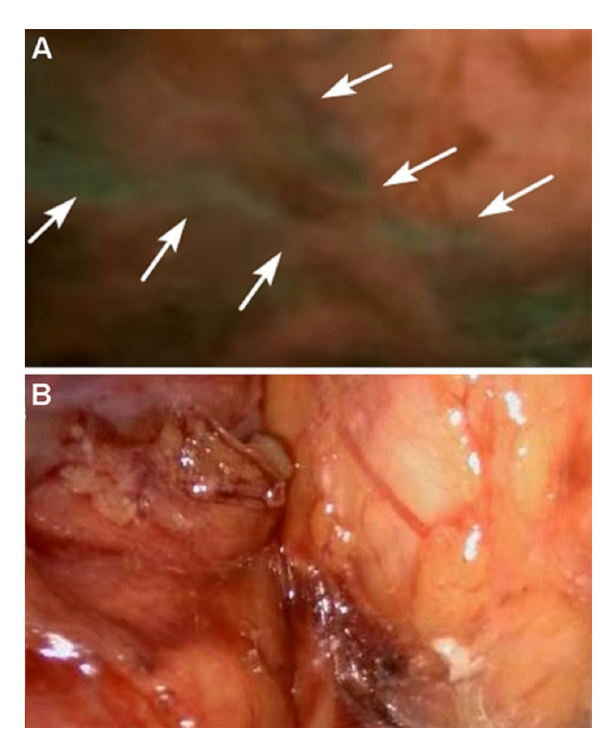
FIGURE 5 Autonomic pelvic nerves under the fuorescence (A) and under the white light (B) , the sacral plexus of autonomic pelvic nerves are displayed very clearly under NIR ray (white arrows) but not clearly under white light. Reprinted with permission from Jin et al. (100). Copyright © The Author(s), under exclusive licence to Springer Science +Business Media, LLC, part of Springer Nature